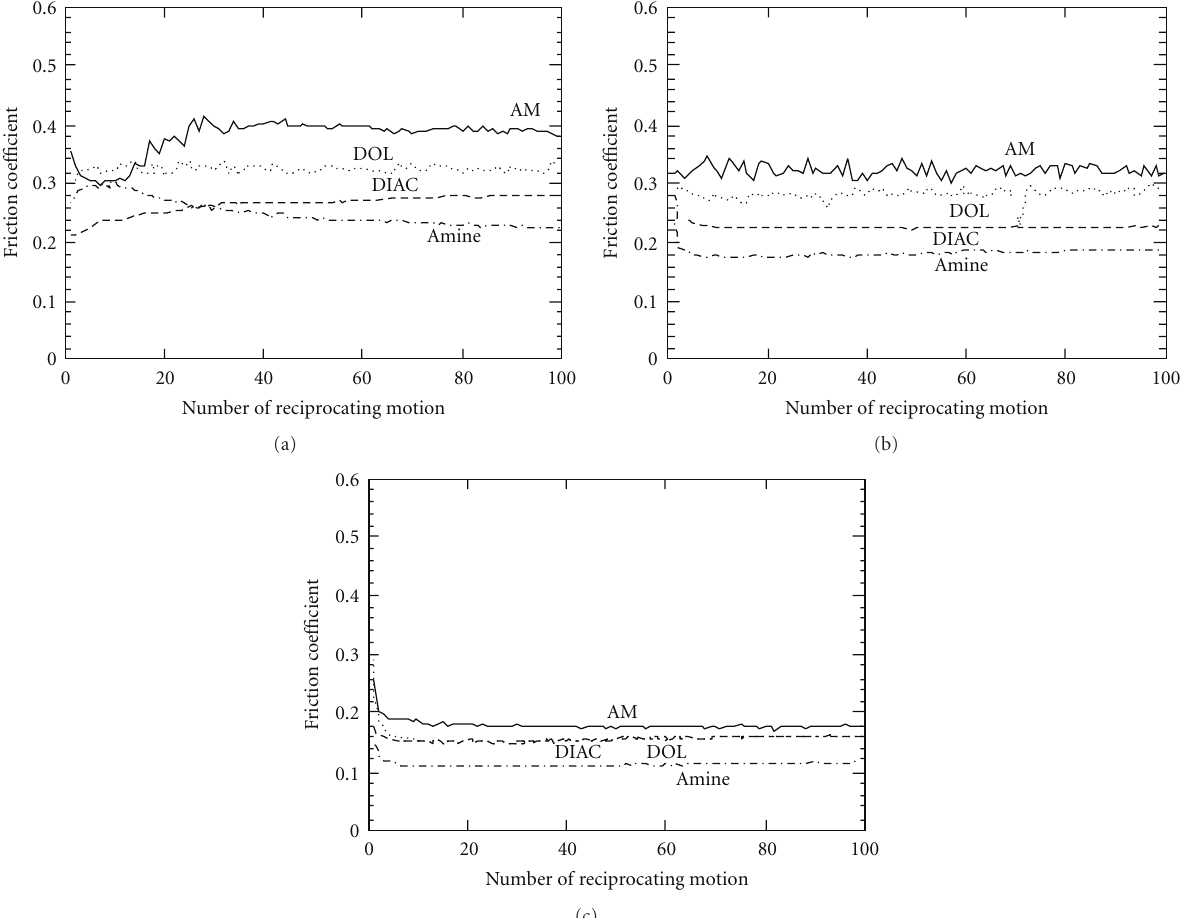
The thickness of the lubricant was almost the same value of 1.2 nm for each PFPE tape. The friction coe ffi cients were stable for the tapes with the 12 nm and 18 nm particles,